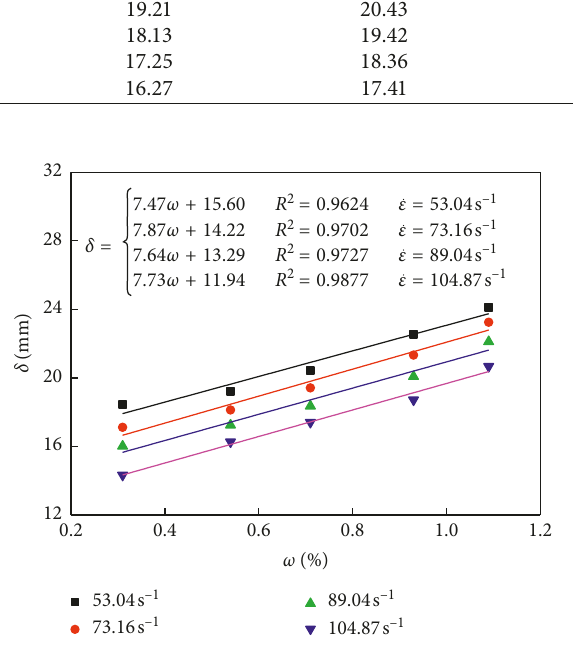
Figure 12: Change of the average grain size against the water